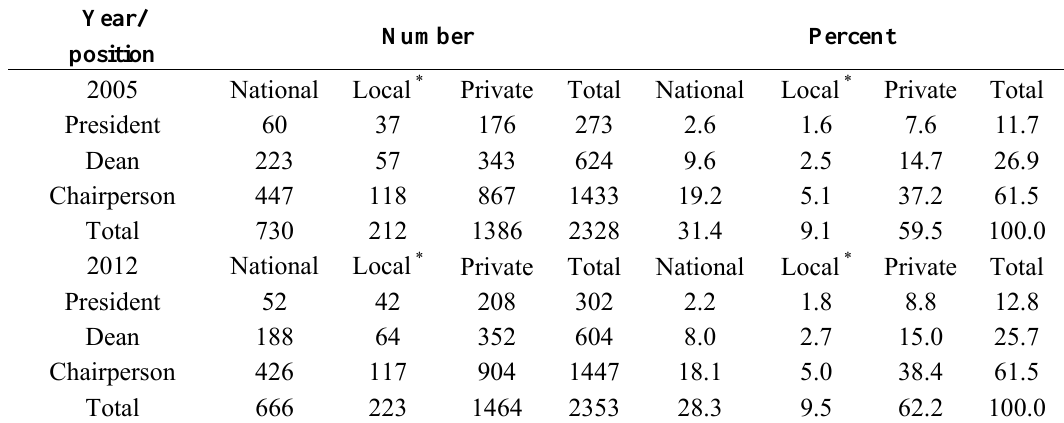
Table 1. Cross-tabulation and distributions of the 2005 and 2012